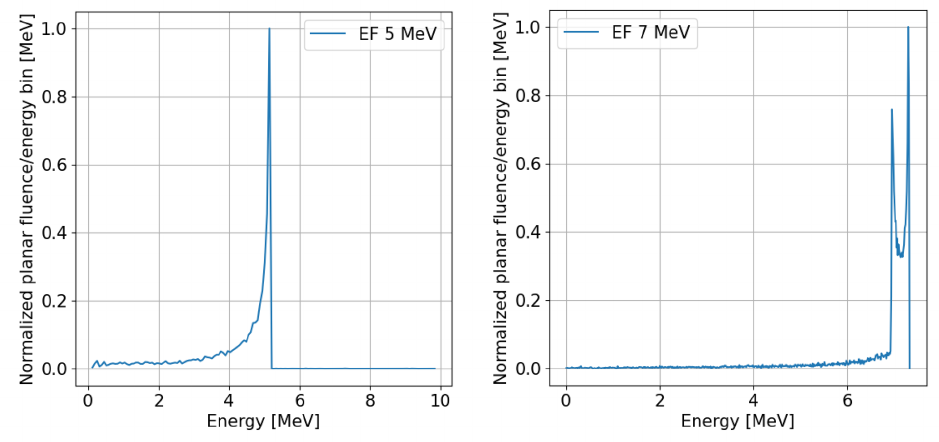
Figure 4. EF at 5 MeV ( left ) and 7 MeV ( right ) normalized planar fluence out of the linac. The energy bin width is 50 keV. The two energy spectra were obtained using the TSTEP code, a derivative of Parmela, for beam dynamics simulation